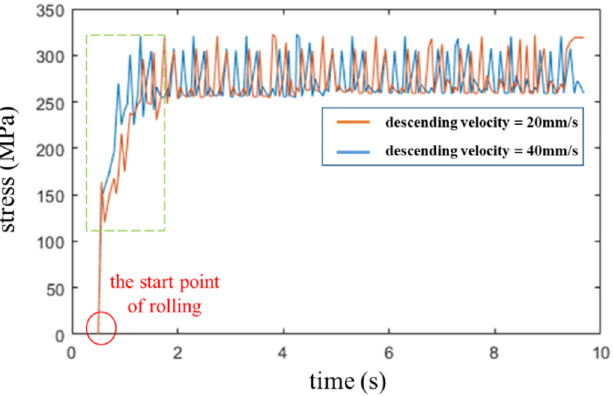
Figure 9. Stress distribution when roller descends at constant velocities (20 and 40 mm/s).